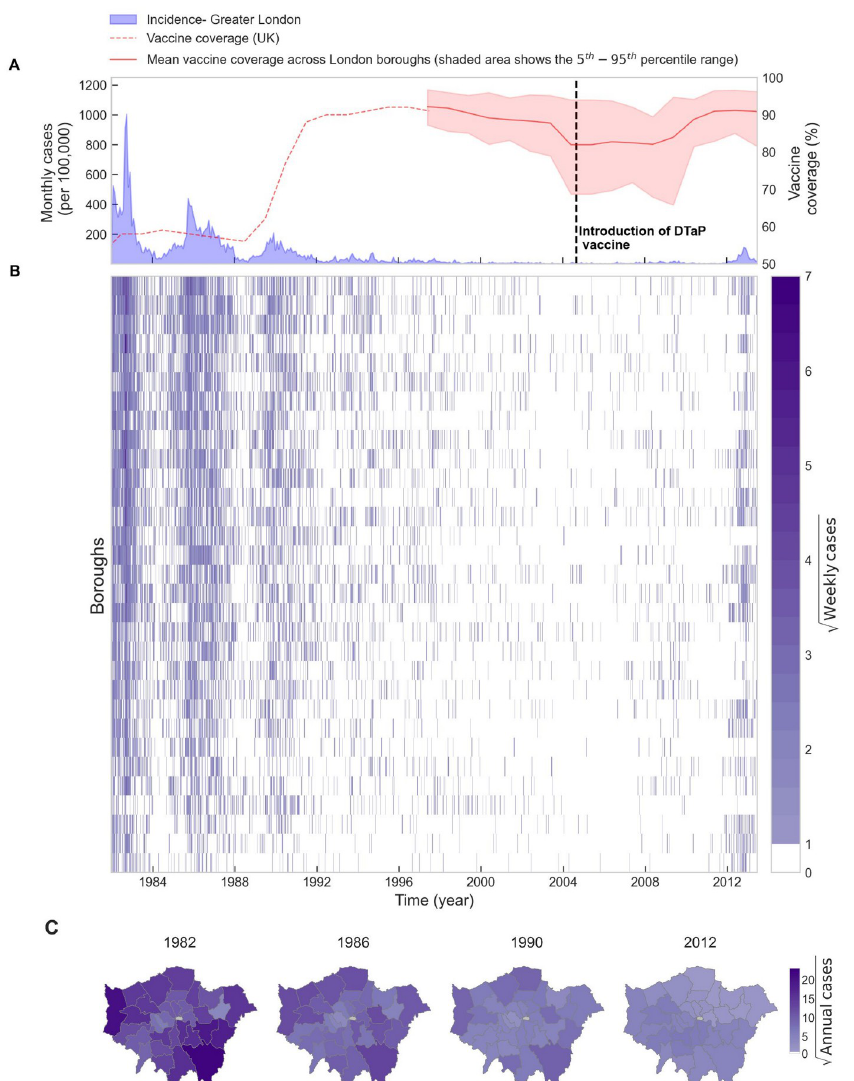
Fig 1. Evolution of pertussis incidence in Greater London. (A) Time series of monthly reported cases in Greater London and annual vaccine coverage rate in the UK (B) Square root of weekly cases of pertussis in London boroughs (C) Choropleth maps of square root of annual cases in the London boroughs at four time snapshots. Map base layers are obtained from London Datastore (https://data.london.gov.uk/dataset/statistical-gis-boundary-files-london) and are available from https://data.london.gov.uk/download/statistical-gis-boundary-files-london/9ba8c833-6370-4b11-abdc- 314aa020d5e0/statistical-gis-boundaries-london.zip (The digital boundary file contains Office for National statistics data Crown copyright and database (2012) and contains Ordnance Survey data Crown copyright and database